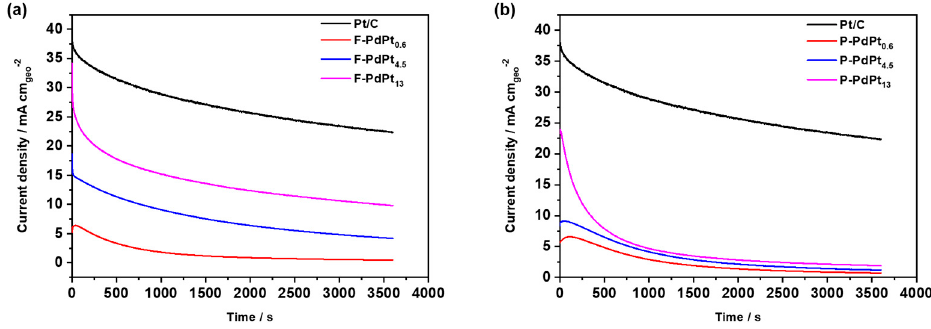
Figure 6. Chronoamperometry curves of ( a ) F-PdPt and ( b ) P-PdPt core–shell nanocubes with different Pt content in aqueous CH 3 OH (1 M) + KOH (1 M). Current was recorded at − 0.2 V for 3600 s.